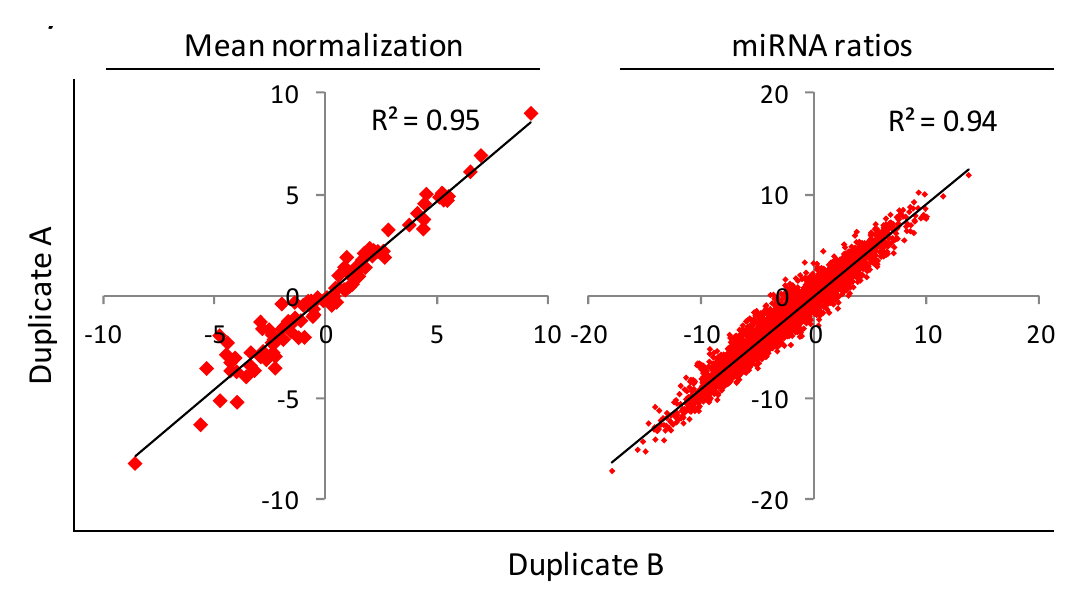
Figure 2. Scatter plots showing the correlation using the mean normalization method and the miRNAs ratios tool, between two biological replicates spotted on microfluidic cards analyzed for the reproducible 100 miRNAs and the respective 4,950